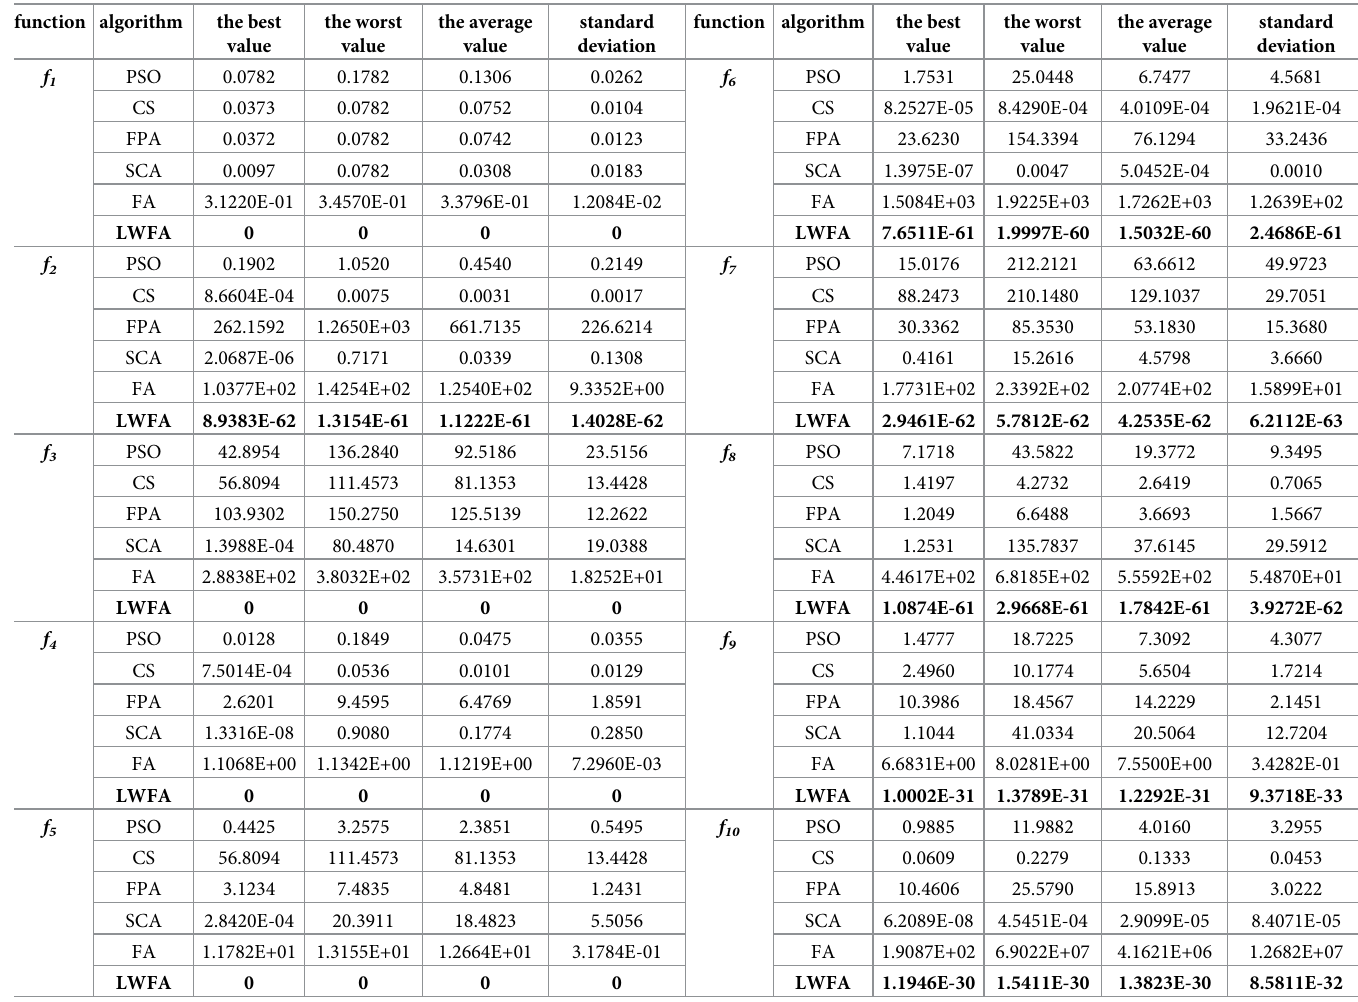
Table 6. The optimization result of 10 benchmark functions for different algorithms (D = 30). function